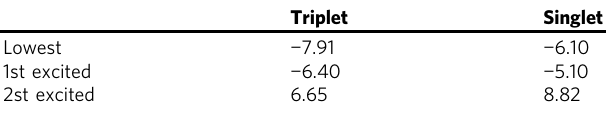
Table 1 Excitation energies ε u of low-lying excitons of the (3, 3) tube obtained from fi rst-principles many-body perturbation theory in units of